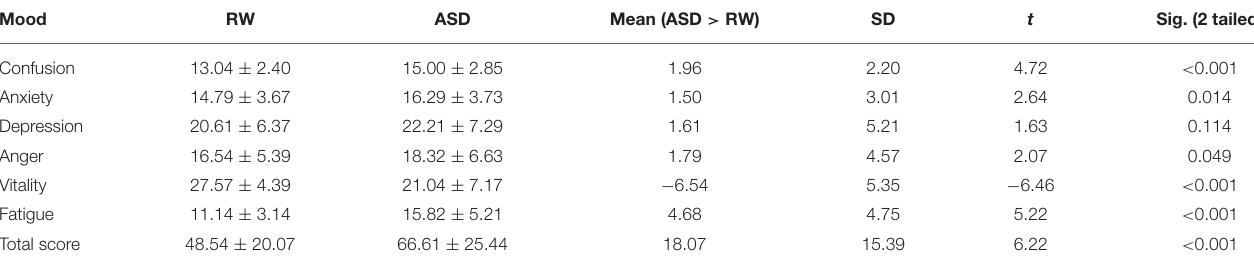
TABLE 1 | POMS statistics: comparisons between RW and ASD (paired t -test, n = 28).